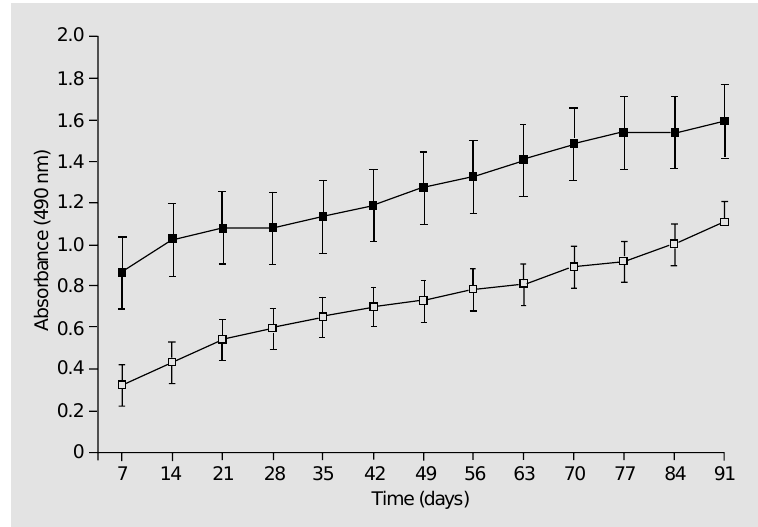
Figure 4 - Humoral immune response elicited by BCG. BALB/c mice were immunized iv with 1.5 x 10 6 CFU of O-BCG (open squares) or ID-BCG (filled squares). Blood samples were collected just before immunization and then at 7-day intervals until day 91. Anti-BCG antibodies were detected by ELISA. Each point represents the mean ± SD of triplicate readings of the sera diluted 1/1000 (O-BCG) or 1/4000